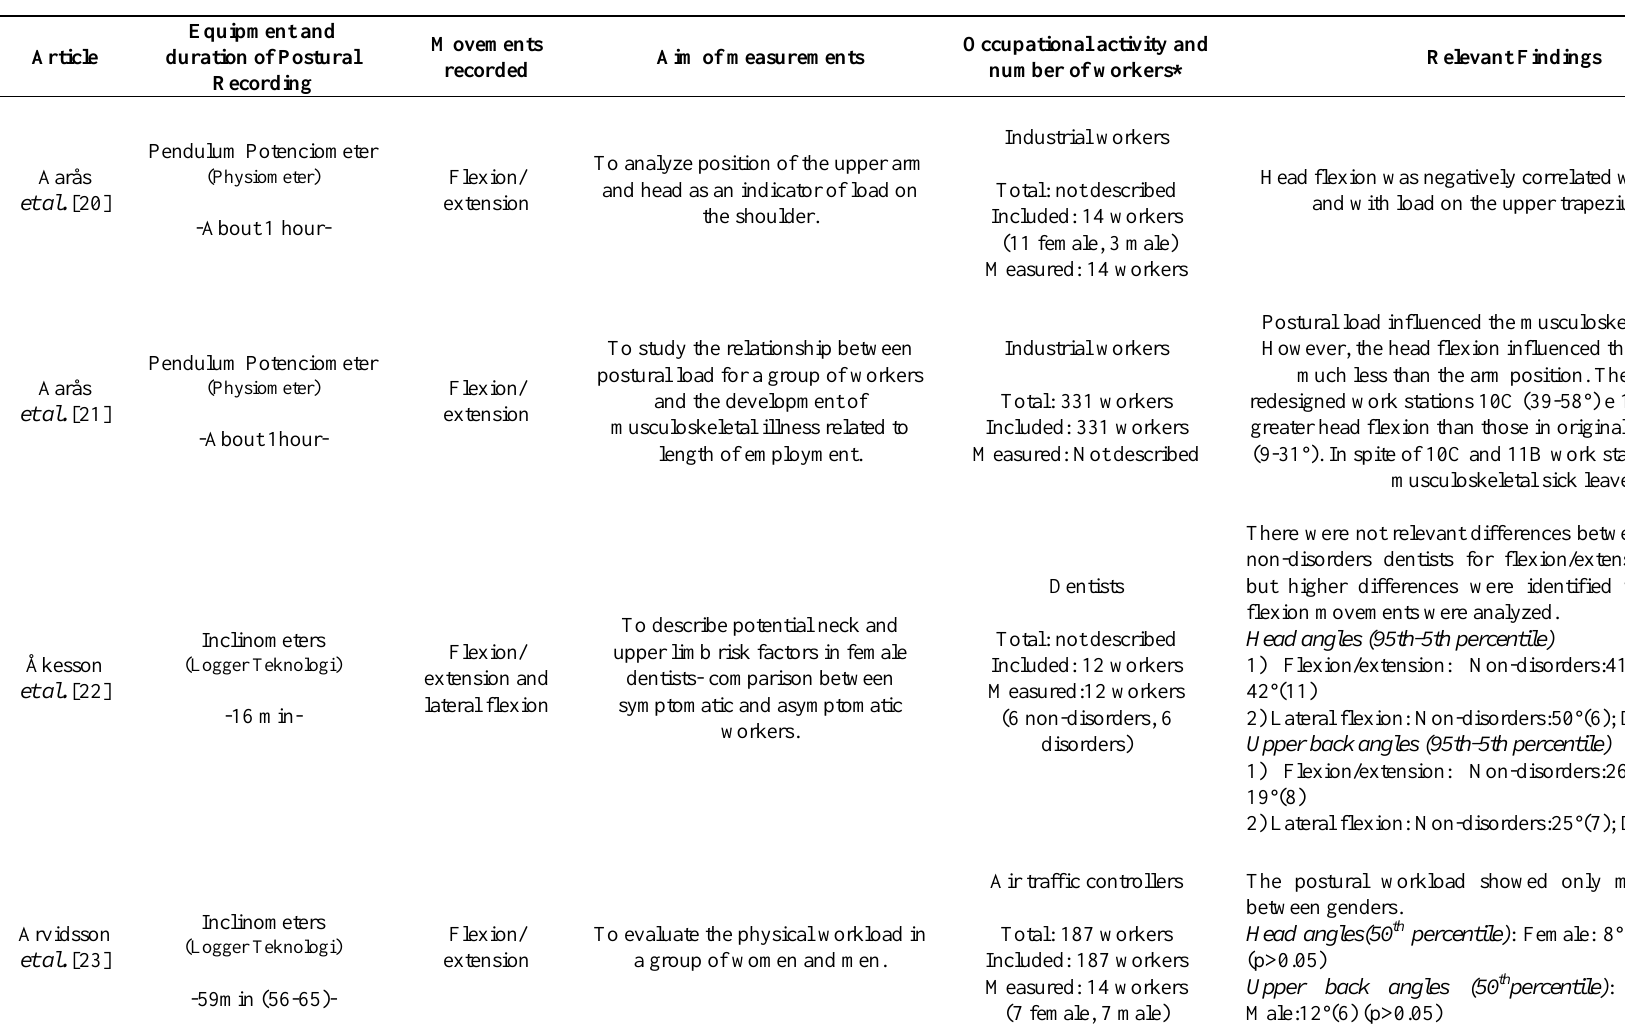
Table 2. Used equipment, duration of the recording, objective of the measurements, occupational activities and relevant